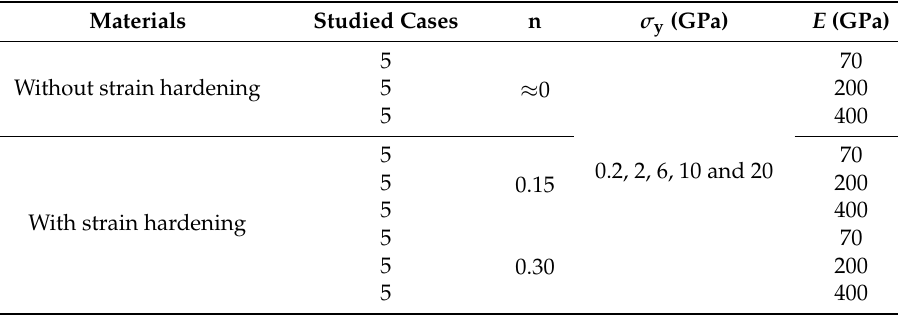
Table 2. Mechanical properties of the materials used in the numerical simulations.